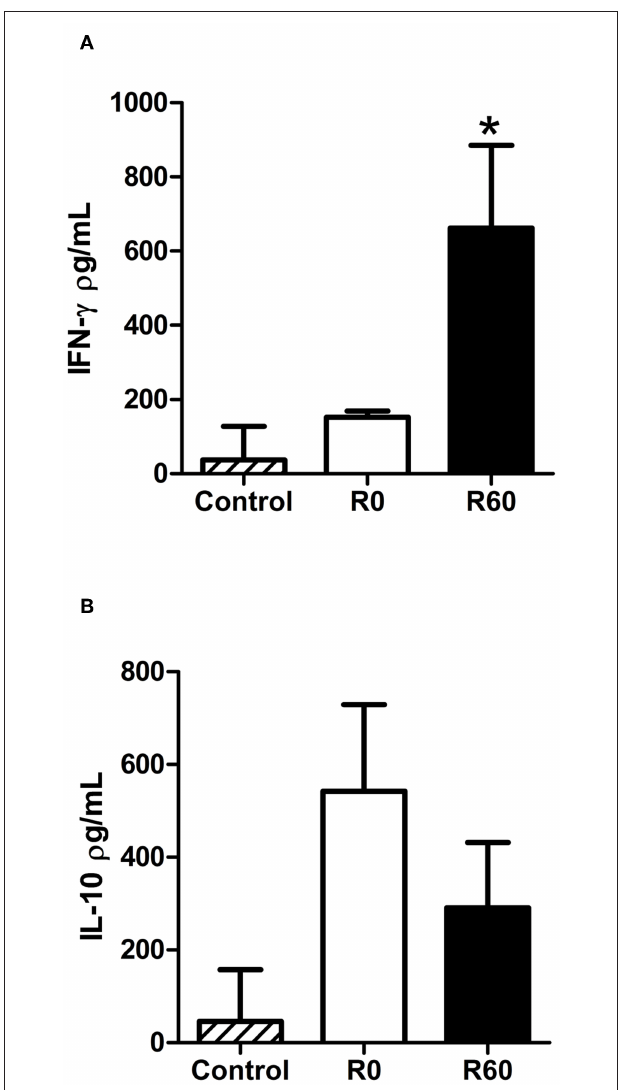
FIGURE 3 | Comparison of cytokine levels in spleen culture supernatants from BALB/c infected with R0 and R60 cell lines after 2 weeks of infection. For infection, 1 × 10 6 parasites were inoculated at the right footpad. Two weeks later, the animals were euthanized and RPMI medium (34 ◦ C, 5% C0 2 ) was used to cultivate spleen cells. The cultures were stimulated with soluble Leishmania antigen (SLA). Negative controls were non-stimulated spleen cells. 48h after the stimulation, supernatant was collected and an ELISA assay was performed. (A) Levels of specific IFN- γ observed in spleen culture supernatants from BALB/c infected with R60 as compared to the levels produced by cells from mice infected with R0. (B) IL-10 levels in supernatant of splenocytes from R0 and R60. Bars represent mean values of three biological replicates from four infected BALB/c footpads, plus standard deviation of the mean. *indicates p ≤ 0.05 (Two-way ANOVA with Bonferroni